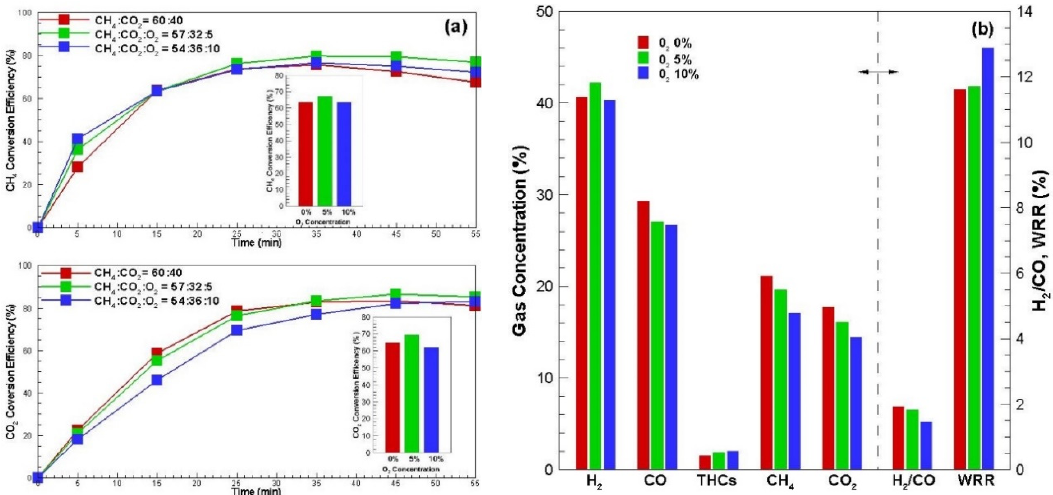
Figure 6. Reforming characteristics of biogas-oxygen effect. ( a ) CH 4 and CO 2 conversion efficiencies and ( b ) average concentration of the product gas, H 2 /CO ratio and weight reduction rate.